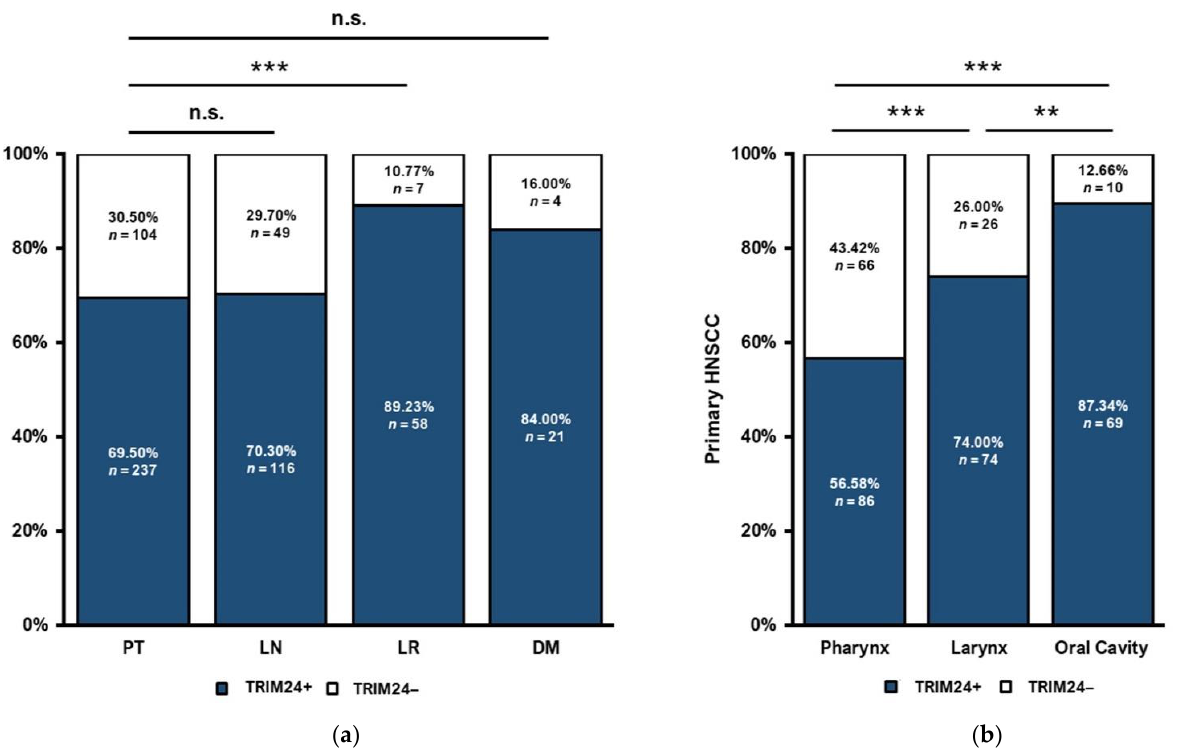
Figure 2. TRIM24 expression in the tissue of PTs, LNs, LRs, and DMs and in different HNSCC tumor sites. ( a ) TRIM24 is expressed more frequently in the tissue of LRs. There are significantly more TRIM24+ LRs than PTs (Chi-square test, p = 0.01). There are no significant differences between PTs and LNs and PTs and DMs (Chi-square test, p > 0.05). ( b ) Most TRIM24+ tumors could be found in the oral cavity, compared to laryngeal HNSCCs (Chi-square test, p = 0.002) and pharyngeal HNSCCs (Chi-square test, p < 0.001). Laryngeal HNSCCs are significantly more often TRIM24+ than pharyn- geal HNSCCs (Chi-square test, p = 0.001). (n.s. = not significant, ** p ≤ 0.01, *** p ≤ 0.001).